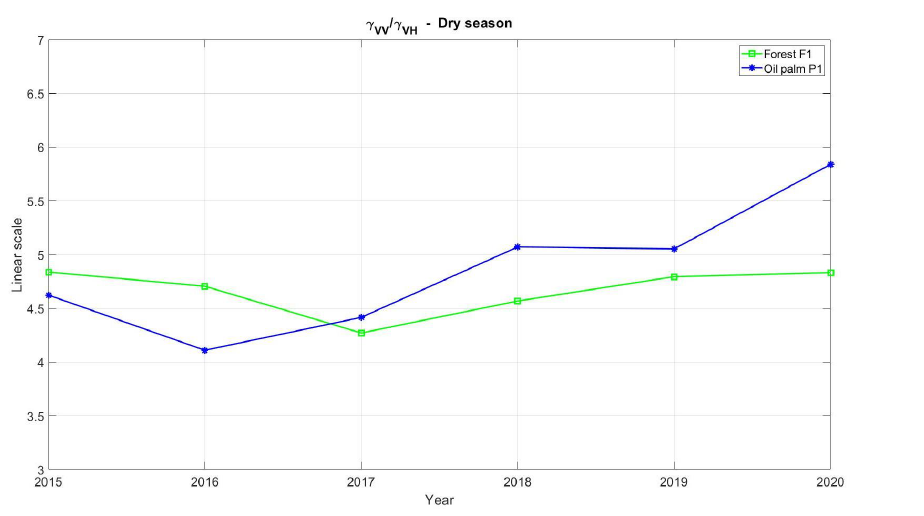
Figure 11. Time series of VV/VH ratio for tropical forest and oil palm plantations (F1 and P1 polygons) for the dry